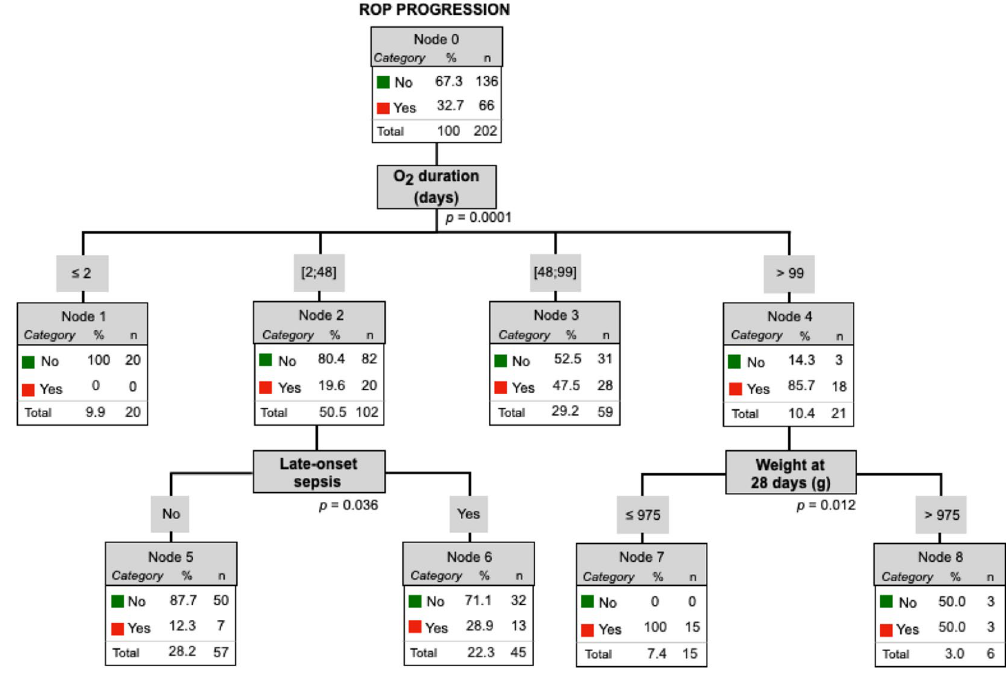
Figure 3. Tree algorithm for ROP progression. *p <